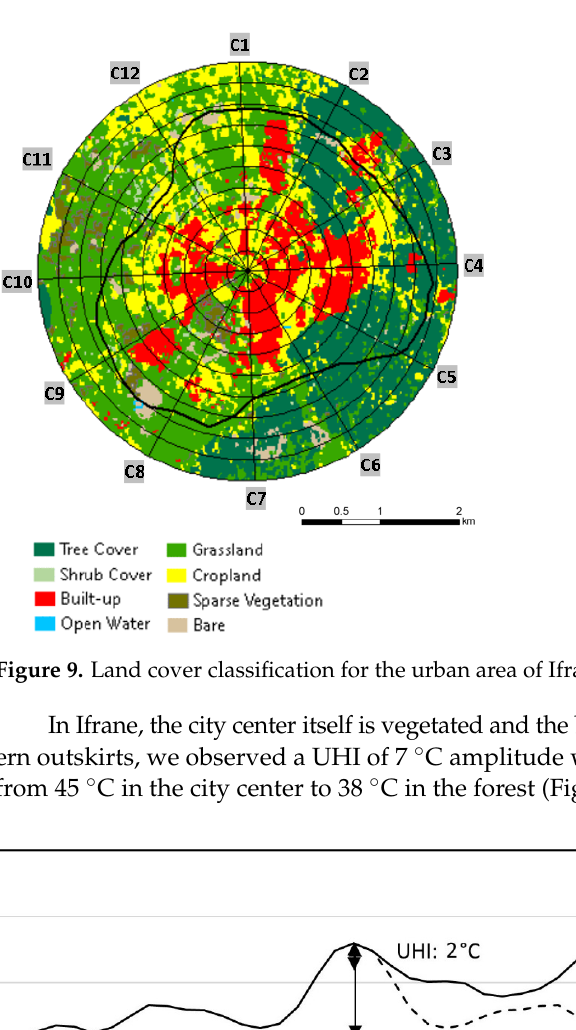
Figure 9. Land cover classification for the urban area of Ifrane (buffers shown every 270 m).